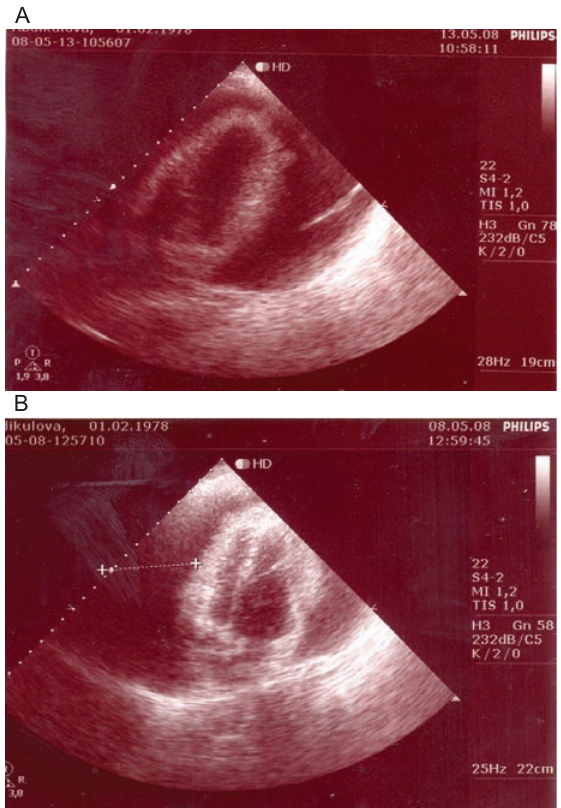
Figure 1. Four-chamber (A) and two-chamber (B) apical echocardiographic views of gross pericardial effusion with fibrin adhesions in a 30-year old pregnant woman with